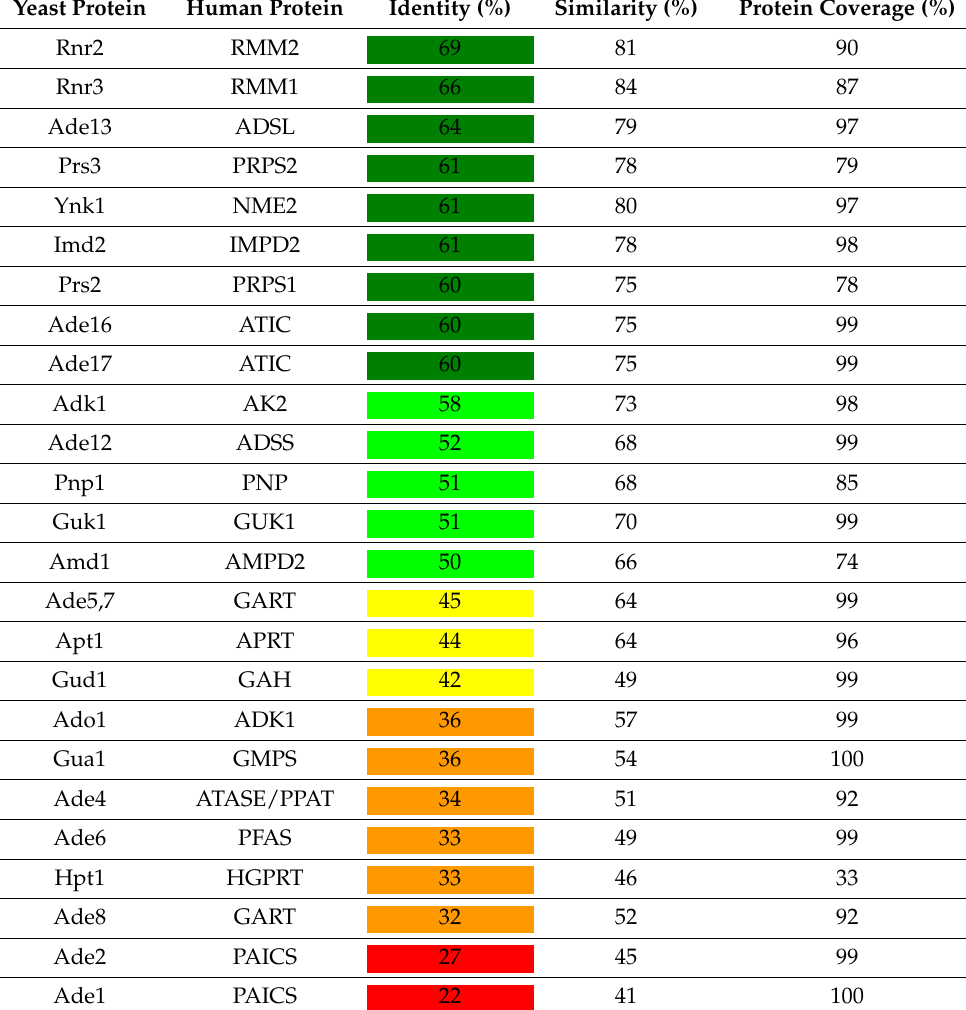
Table A3. Comparison of the yeast and human purine pathway enzymes depicted in Figure 1. Identity and similarity scores were obtained from the Proteome TM platform [64]. For each enzymatic activity, only the best score obtained between yeast and a human ortholog was shown. Protein coverage refers to the fraction (%) of the entire protein (the smallest of the two orthologs) used in the alignment for determination of identity and similarity